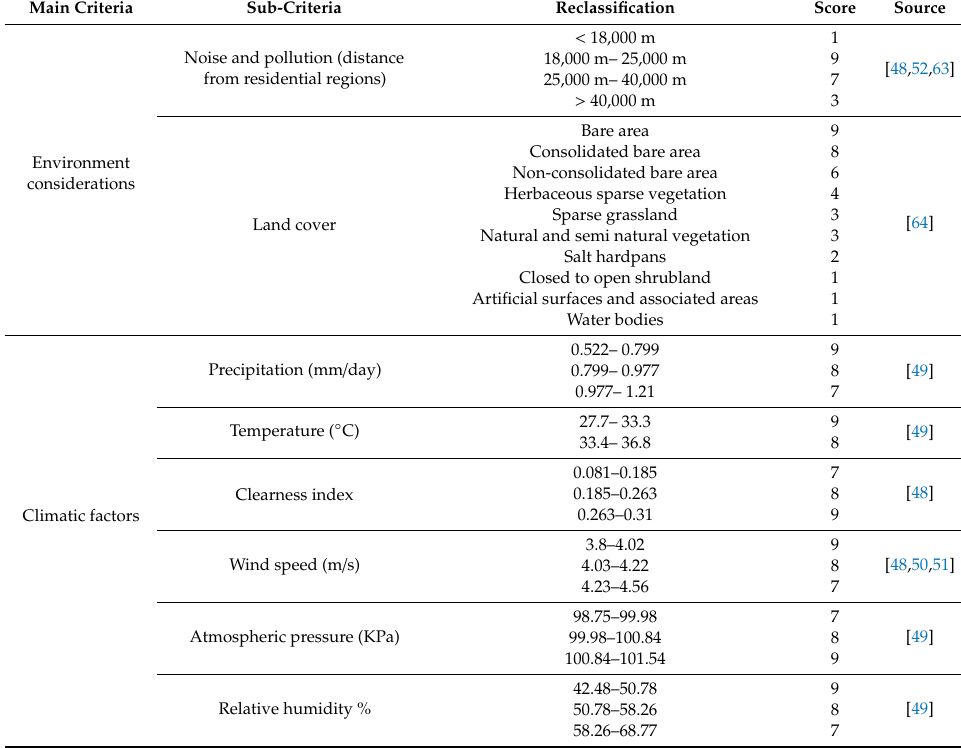
Table 3. Reclassification of input